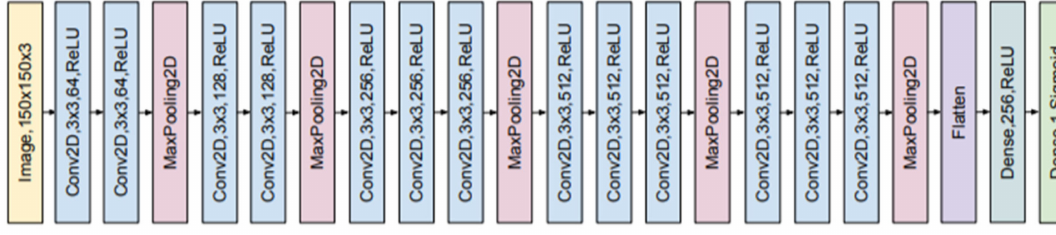
Figure 11. Structure of a pre-trained convolutional neural network with 21 layers (VGG-16).